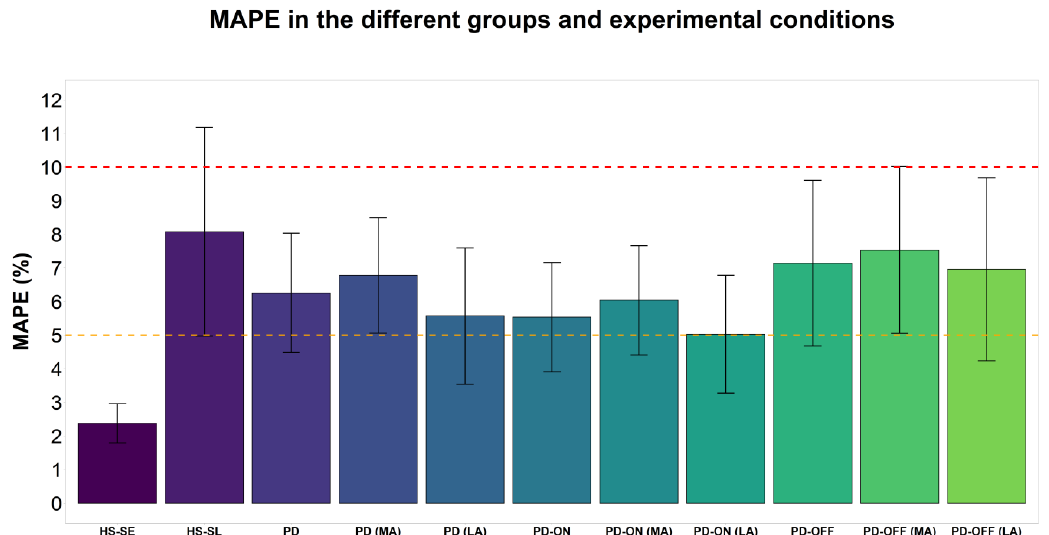
Figure 1. MAPE between the number of steps recorded by GV4 and manual counting in the two groups and in the different experimental conditions. In HS, data are reported for self-selected speed and slow speed. In PD patients, data are reported for the overall population, in ON, in OFF, and for the most- and least-affected body sides. Columns represent the mean of MAPE and the vertical bars represent the CI 95% upper and lower bounds. Two red and orange horizontal dashed lines were added to mark the cut-offs of 10% and 5%, respectively. HS-SE: Healthy subjects at self-selected speed; HS-SL: Healthy subjects at slow speed; LA: Least-affected side; MA: Most-affected side; MAPE: Mean absolute percentage error; PD: Parkinson’s disease.